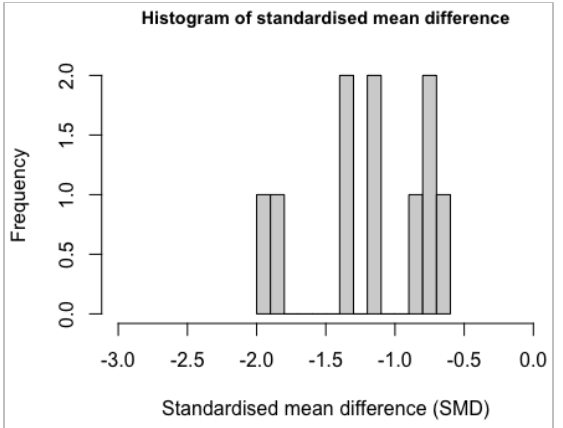
Figure A7. The distribution of the SMD of HC versus MCI_AD is not too dissimilar to a normal distribution, considering the limitations of a small sample.